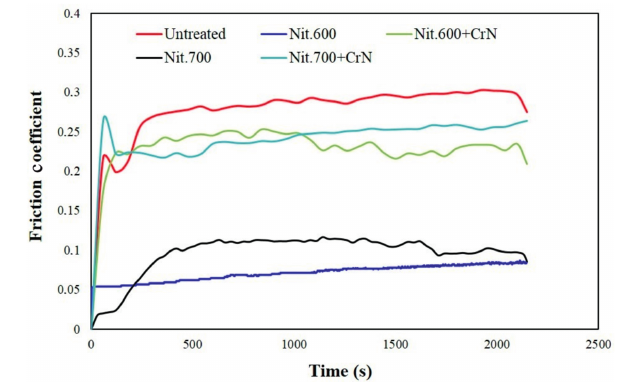
Figure 3: Surface morphology of the treated specimens: (a) Nit.600, (b) Nit.600 + CrN, (c) Nit.700, and (d) Nit.700 + CrN.